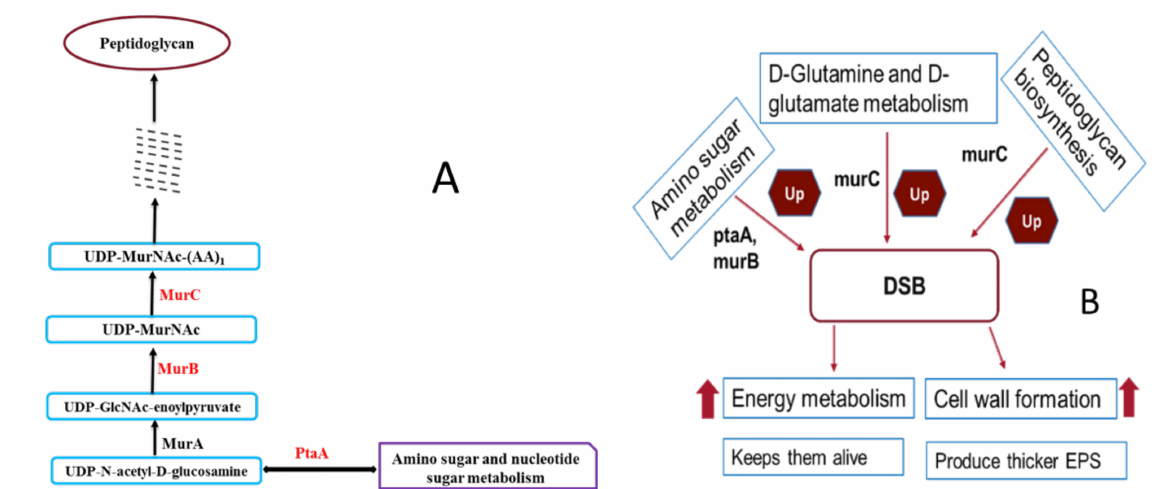
Figure 3. ( A ) Selected part of the peptidoglycan biosynthesis pathway and link with amino sugar metabolism; ( B ) Potential regulators of S. aureus biofilm formation in the DSB identified from TMT- based